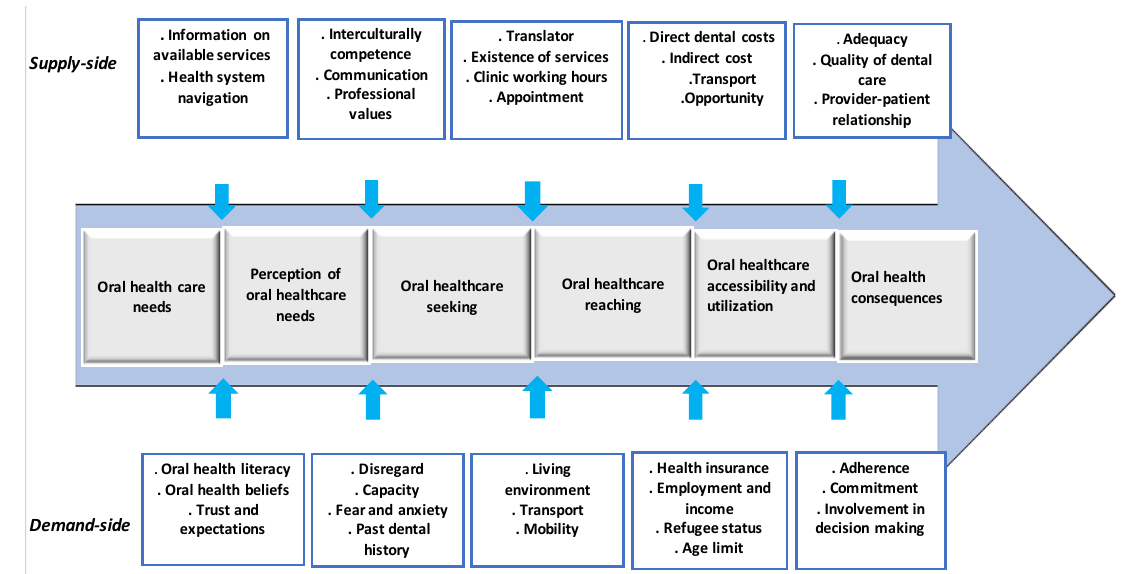
Figure 1. Conceptualization of oral healthcare access among ERNRAS in Heidelberg, Germany, adopted from the access framework of Levesque et al. (2013) [53].